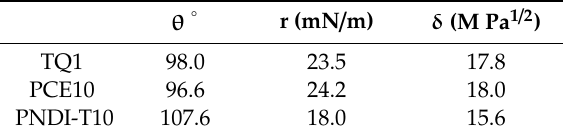
Table 2. Contact angle, surface energy, and solubility parameters of TQ1, PCE10, and PNDI-T10 pure